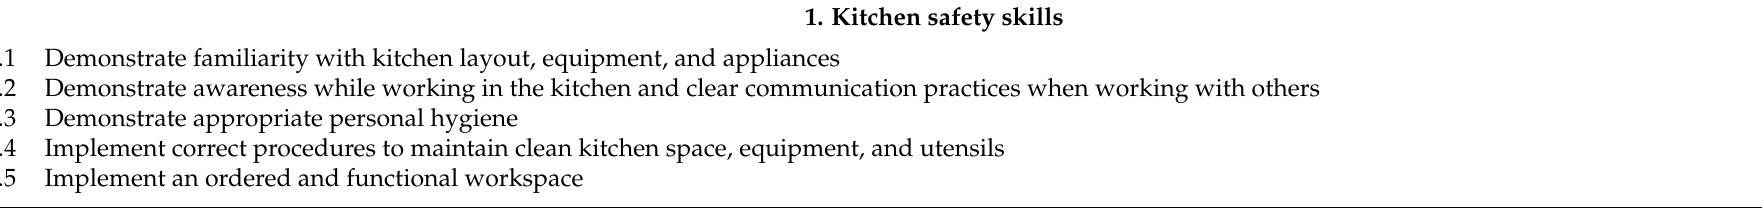
Table 1. The Cook-Ed TM matrix to guide skill selection in culinary education programs that target improved diet quality and